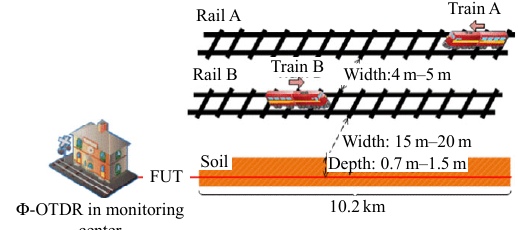
Fig. 19 Relative positions between the optical cable, trains, and railways. ) u . a . on ( a ti b r V i